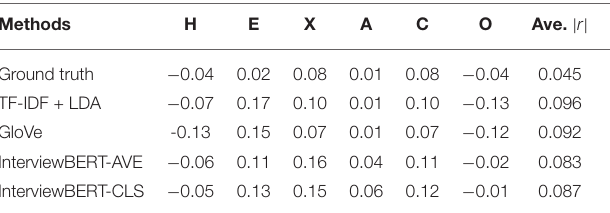
TABLE 3 | Correlation coefficient r between answer length and trait scores predicted by different methods. Methods